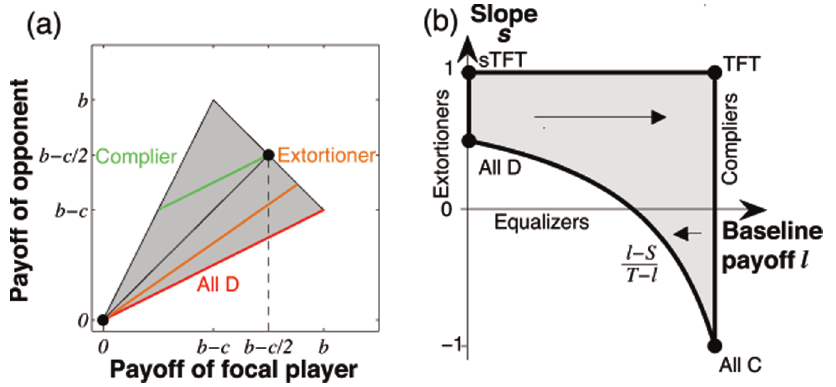
Figure 7. Zero-determinant strategies for the iterated snowdrift game (with b ~ 2 , c ~ 1 , and T ~ b , R ~ b { c = 2 , S ~ b { c , P ~ 0 ). (a) The grey shaded area gives the space of feasible payoff pairs in the snowdrift game. The three colored lines give three examples of possible payoff combinations if the focal player uses a strategy that enforces a linear relation between payoffs. Unlike in the iterated prisoner’s dilemma, the slope of AllD is positive, s ~ ( b { c ) = b . (b) The grey-shaded area depicts the space of possible combinations of baseline payoff l and slopes s that are enforceable in the snowdrift game. A comparison with Fig. 2 shows that the state space differs considerably from the state space of a prisoner’s dilemma game. However, the qualitative dynamics within the state space remains unchanged.